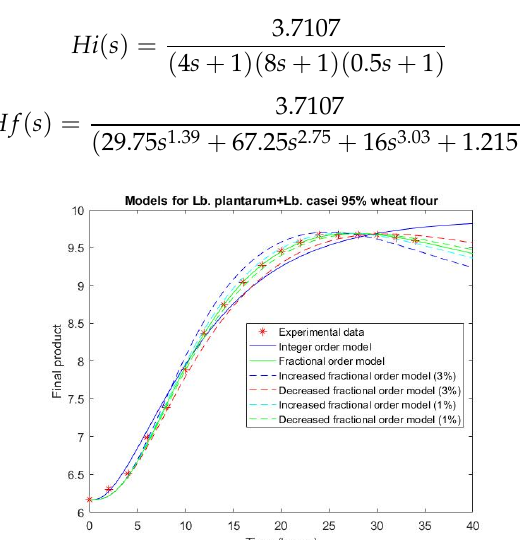
Figure 8. Comparison between simulated and experimental data for experiment 2 using both types of bacteria.